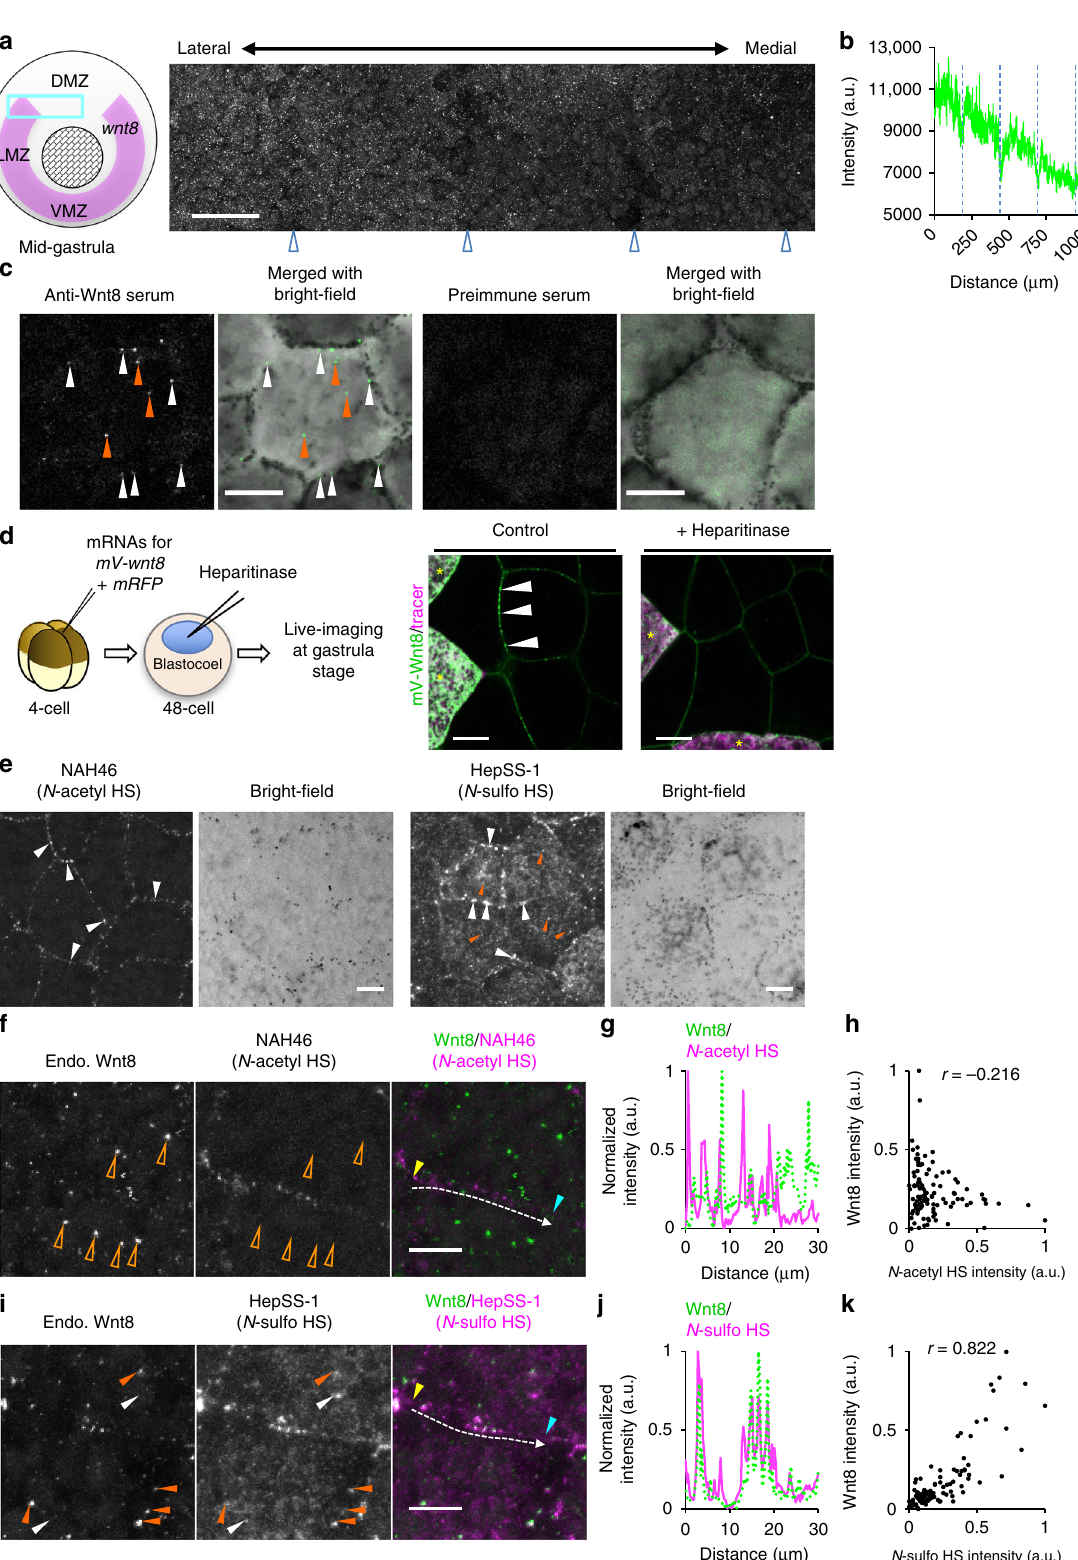
the injection of antisense morpholino oligos (MO) targeting wnt8 (Supplementary Fig. 1c) and was not observed with pre-immune serum (Fig. 2c, right), showing that the staining was spe- ci fi c for Wnt8. Such punctate distribution was also detected in live-imaging of Wnt8 fused with monomeric Venus (mV)